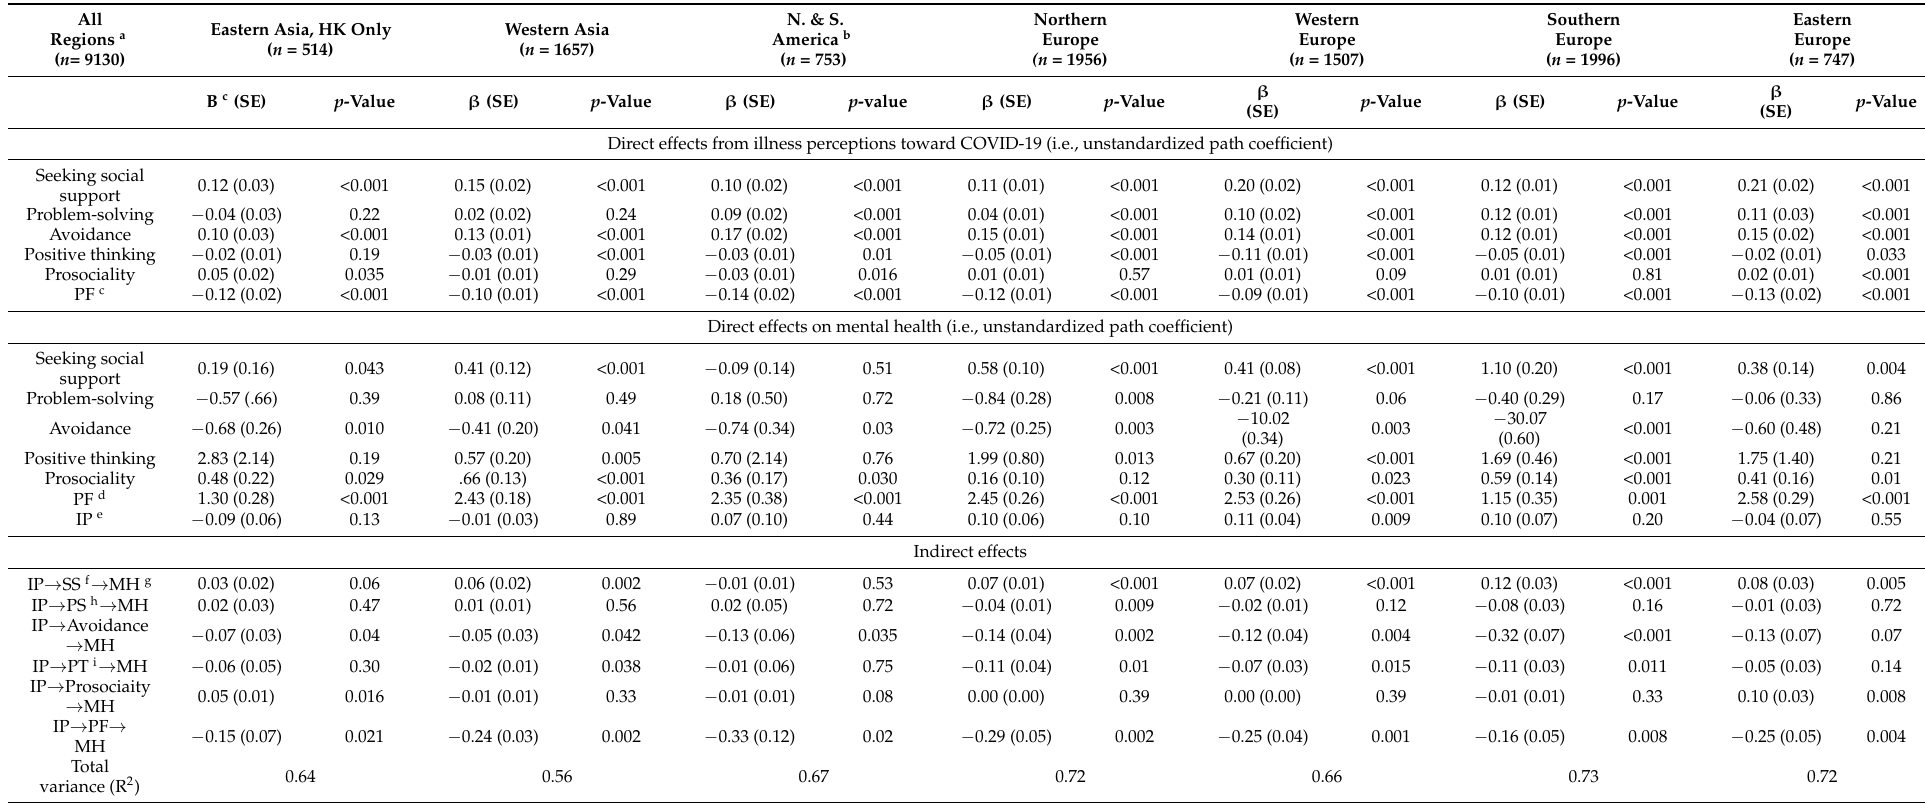
Table 3. Results of unconstrained multiple-group structural equation model by